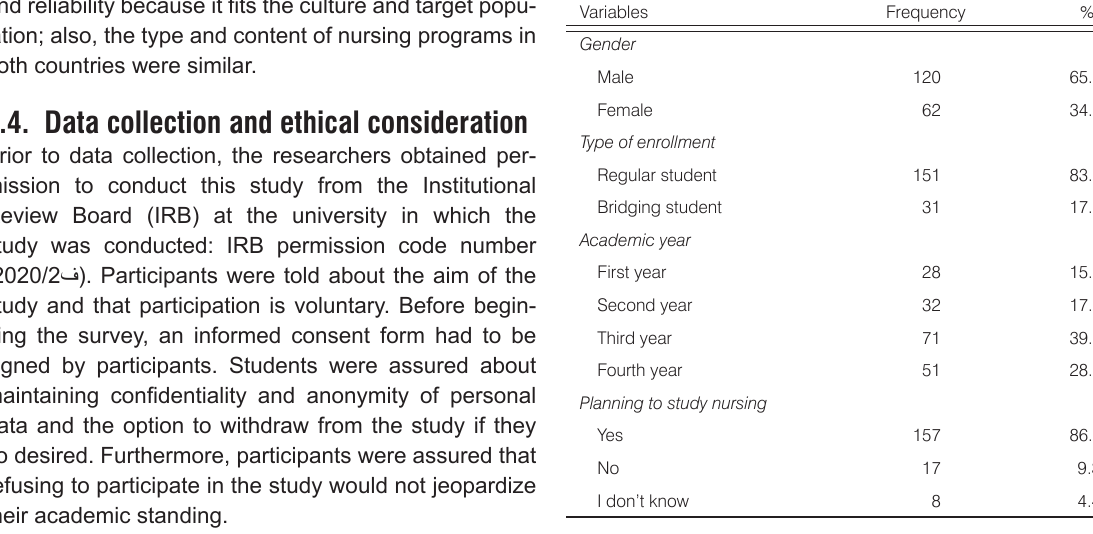
Table 1. Participants’